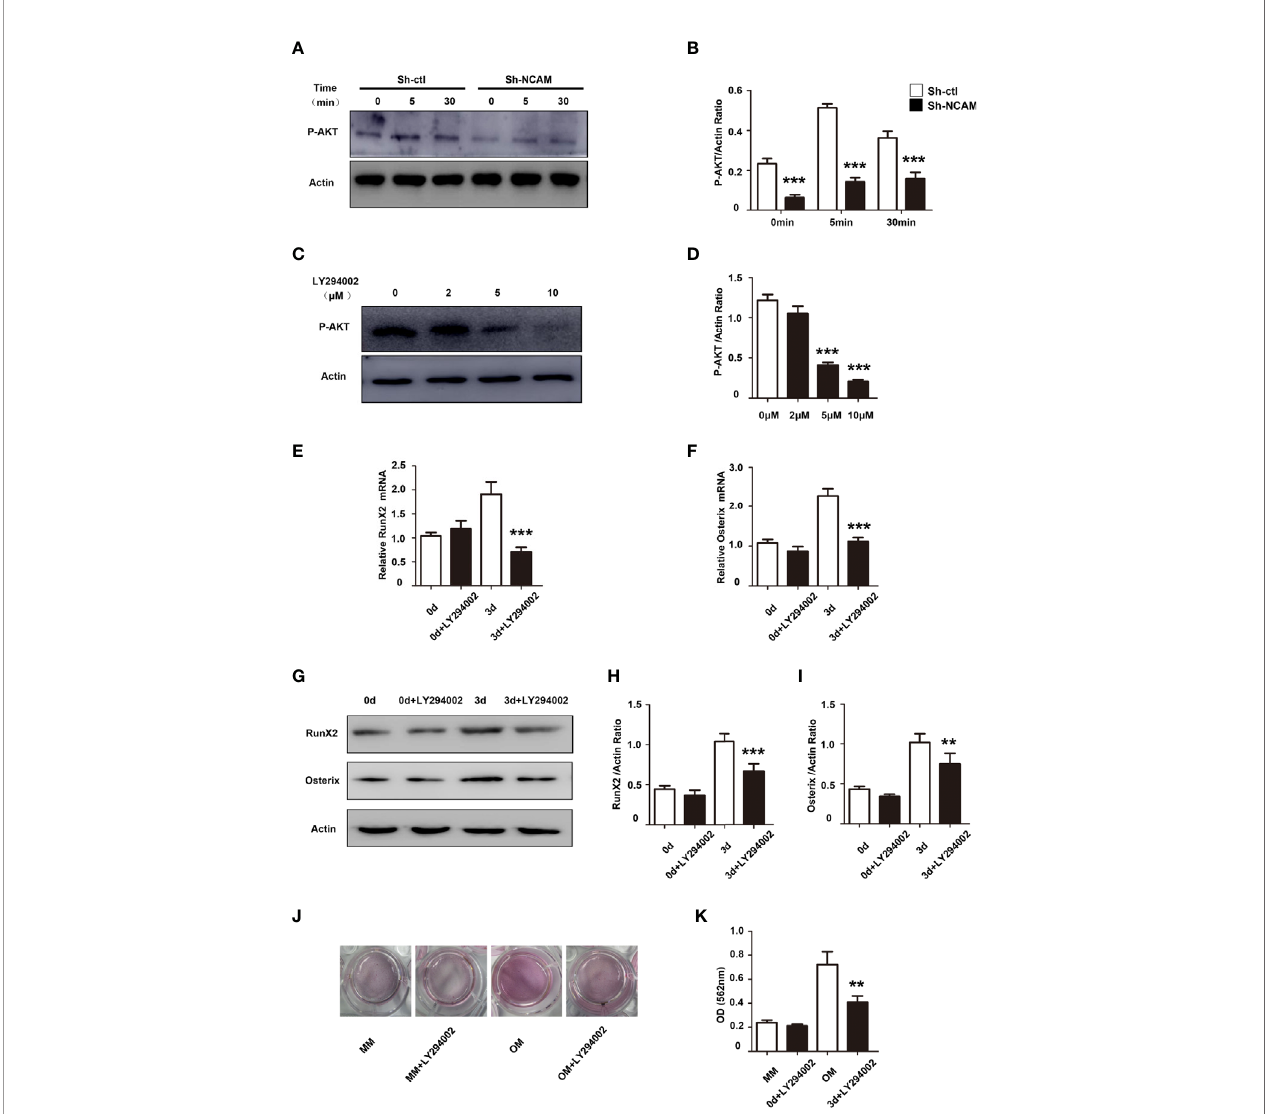
FIGURE 5 | PI3K-Akt signaling contribute to NCAM-mediated osteoblast differentiation. (A) Sh-ctl and Sh-NCAM MC3T3-E1 cells were treated with differentiation media for 0, 5, and 30 min, the phosphorylation of Akt was analysed by immunoblotting. b -actin was detected as a loading control. (B) Level of phosphorylated Akt was quanti fi ed by densitometry and normalized to b -actin (n=3; mean ± SEM; *** p < 0.001, compared with control siRNA group). MC3T3-E1 cells were pretreated with the PI3K-Akt inhibitor LY294002. (C) The expression of phosphorylated Akt was analysed and (D) quanti fi ed by densitometry and normalized to b -actin (n=3; mean ± SEM; *** p < 0.001, compared with cells without LY294002).The expressions of (E) RunX2 and (F) Osterix were examined by real-time PCR (The results are expressed as the mean ± SEM of three independent experiments. *** p < 0.001, compared with cells without LY294002). (G) The expressions of RunX2 and Osterix were analysed by immunoblotting, b -actin was detected as a loading control. Levels of (H) RunX2 and (I) Osterix were quanti fi ed by densitometry and normalized to b -actin (Data are representative of three independent experiments and values are means ± SEM. ** p < 0.01, *** p < 0.001, compared with cells without LY294002). (J) Calcium deposition was assessed by Alizarin red staining. (K) The Alizarin red staining was extracted and quanti fi ed, the wavelength was measured at 562 nm (Data are representative of three independent experiments and values are means ± SEM. ** p < 0.01, compared with cells without